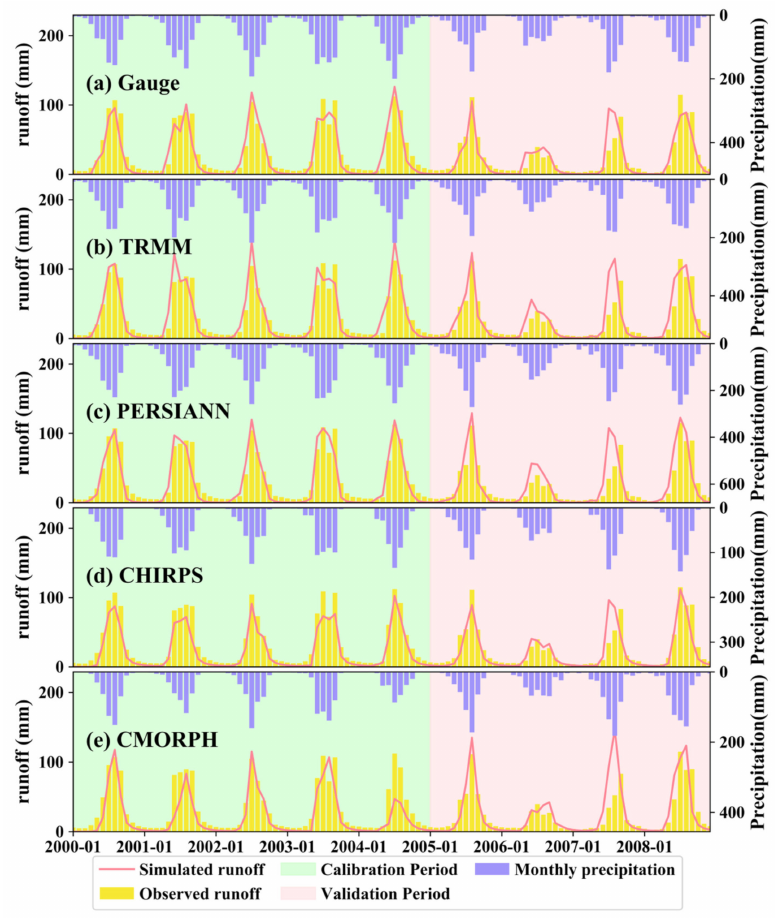
Figure 13. The monthly observed ( Q obs ) and the simulated ( Q sim ) runoff hydrographs for four products and gauges at Lhasa station from 2000 to 2008. The input data of ( a – e ) are Gauge, TRMM, PERSIANN, CHIRPS, and CMORPH, respectively. The calibration period is 2000–2004 and the validation period is